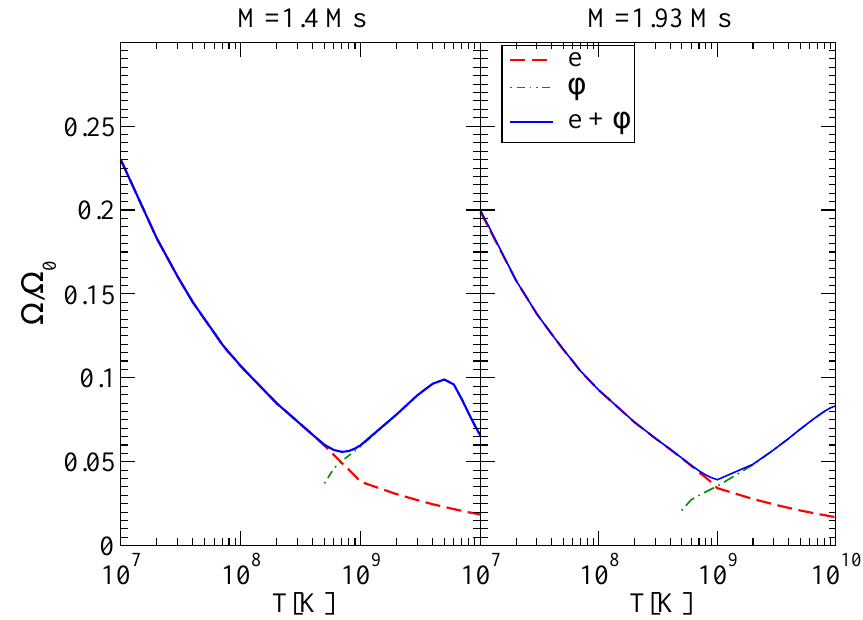
Figure 8. R-mode instability window for superfluid neutron stars. The Kepler (normalized) frequency is displayed for two neutron star masses (1.4 M s and 1.93 M s ) as a function of temperature for the electron, phonon, and electron+phonon dissipative processes. Here, Ω 0 = average mass density of the star. Figure adapted from [7,18]. Adapted from [18] with the permission of AIP